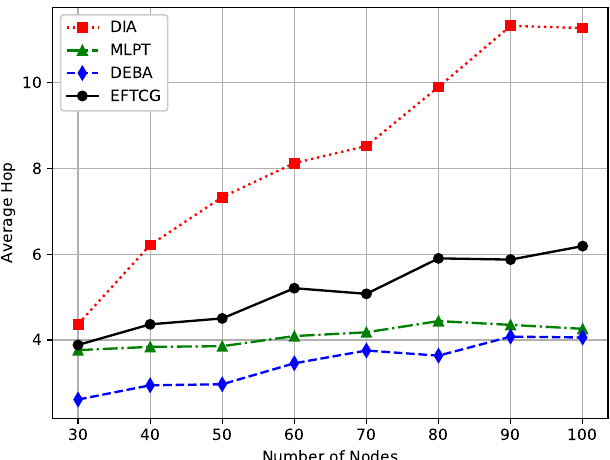
Figure 8. The comparison of the average hop under different algorithms